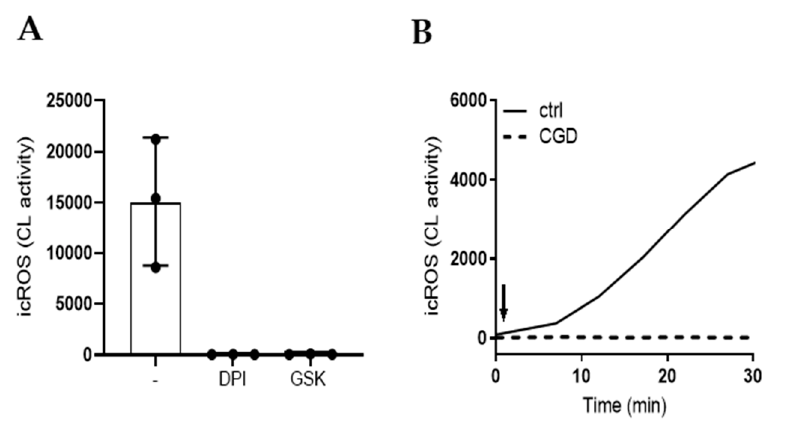
Figure 2. MSU-induced ROS originate from the NADPH-oxidase. ( A ) Neutrophils pre-treated with the NADPH-oxidase inhibitors DPI (10 µ g / mL) or GSK (20 µ g / mL) did not produce icROS in response to MSU crystals (300 µ g / mL); peak values +/ − SD are shown ( n = 3). ( B ) Neutrophils from a patient with CGD (broken line) did not produce icROS in response to MSU crystals (300 µ g / mL) as compared to control neutrophils (solid line). Arrows indicate addition of stimuli.